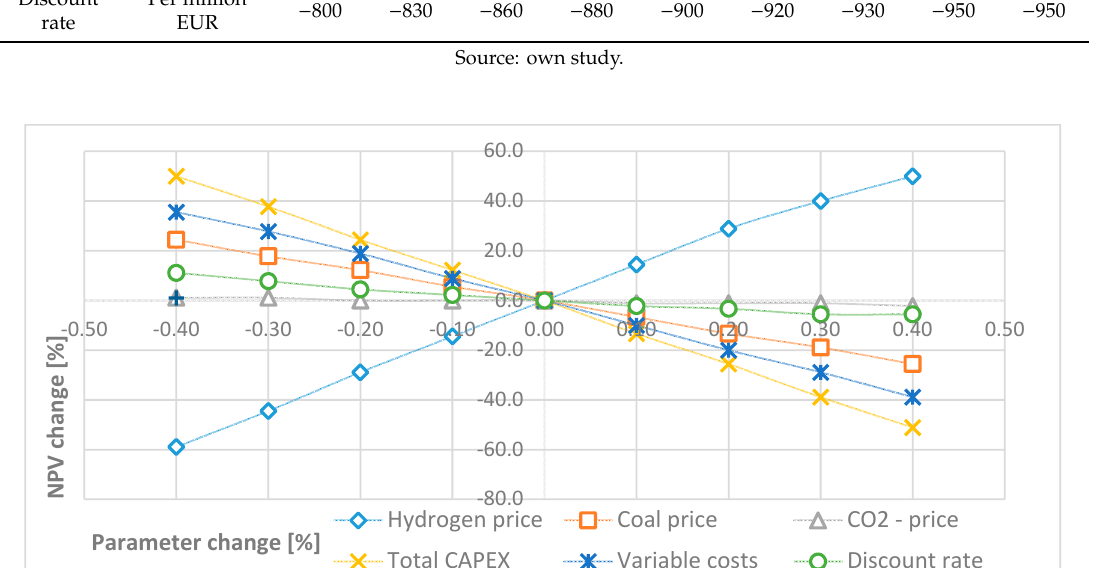
Table 12. Sensitivity analysis for lignite gasification w/ CCS (L_H2_1).